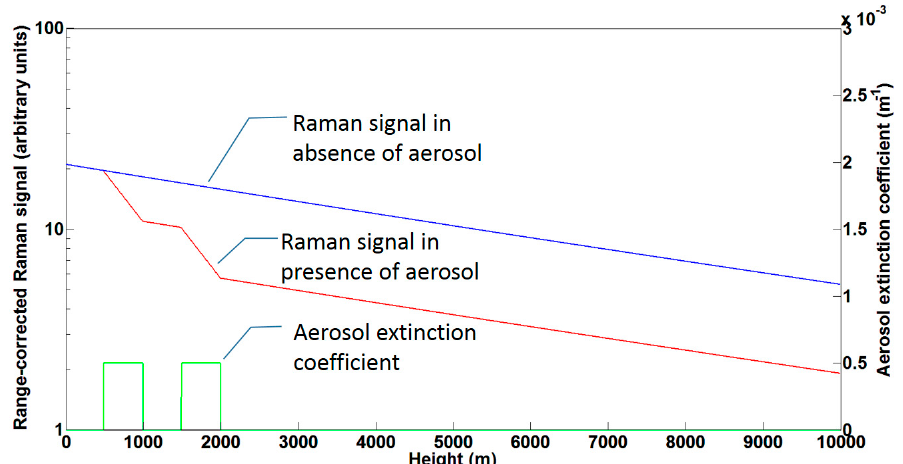
Figure 2. Illustration of the principle of the Raman technique to measure the aerosol extinction. The range-corrected Raman signal for a purely molecular atmosphere is represented by the blue curve. The red curve represents the range-corrected Raman signal if there were two aerosol layers (between 500 m and 1000 m, and between 1500 m and 2000 m) with 5 × 10 − 4 m − 1 aerosol extinction coefficient (green curve).